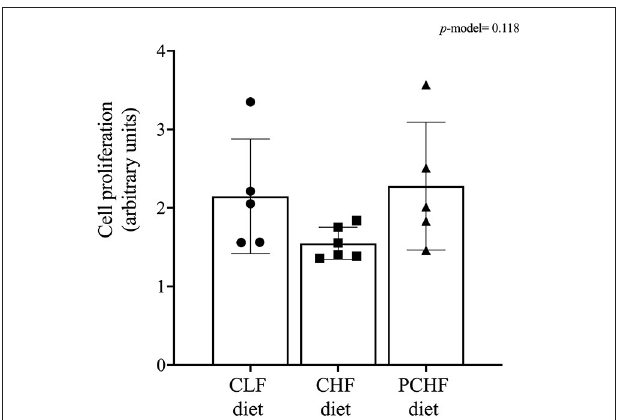
FIGURE 2 | Effect of diet on T-cell proliferation following stimulation with anti-CD3/anti-CD28 in male Wistar rats. Values are means ± SEM. p -model = 0.118. CLF, control low-fat; CHF, control high-fat; PC, phosphatidylcholine; PCHF, PC high-fat.